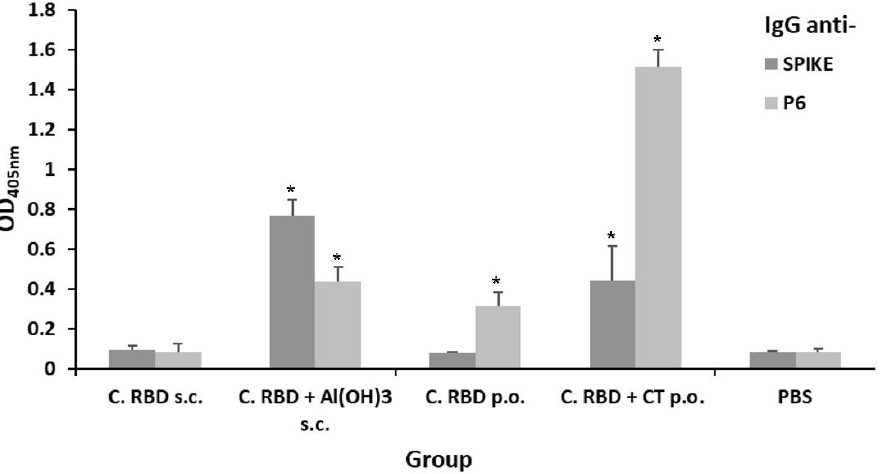
Figure 3. Evaluation of the systemic humoral response (total IgG) induced by the algae-made RBD. The IgG levels were measured in sera samples (1:100 dilution) by ELISA using either spike or P6 as the target antigen. Treatments for each experimental group are described in Table 1. Error bars represent standard deviations. * denotes statistically significant differences versus the PBS group ( p < 0.05).